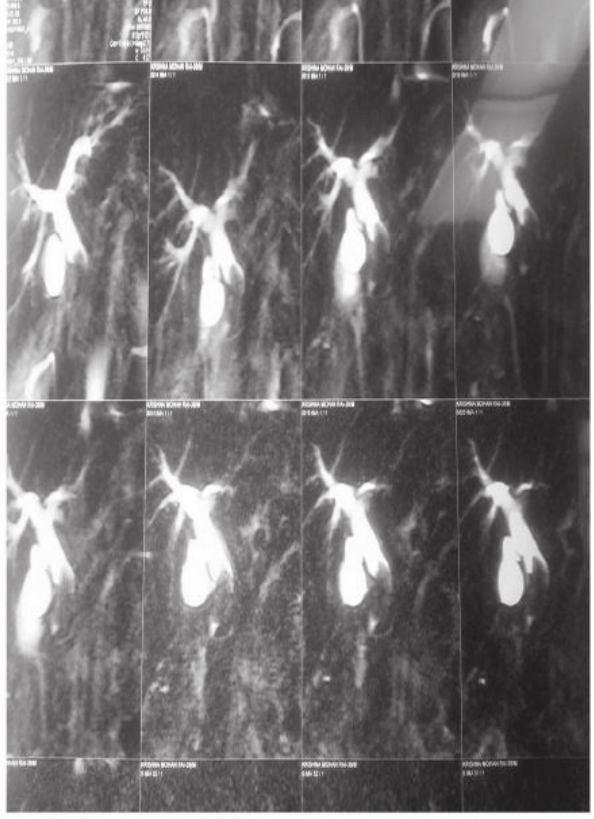
Figure 1: MRCP with meniscus